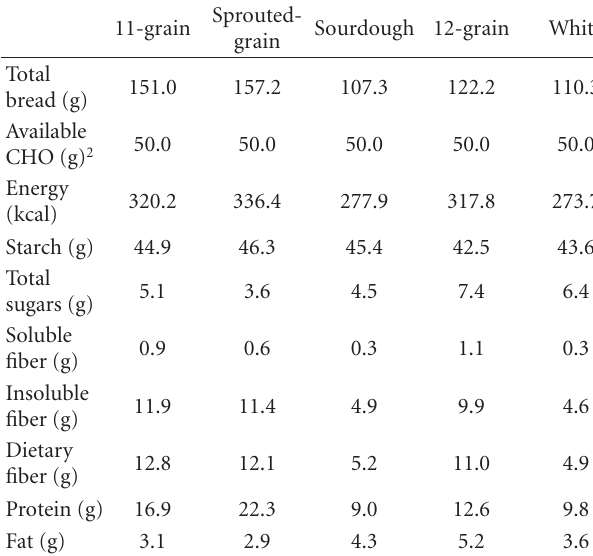
Table 1: Nutrient composition of the test breads delivering 50g available CHO (part 1) 1